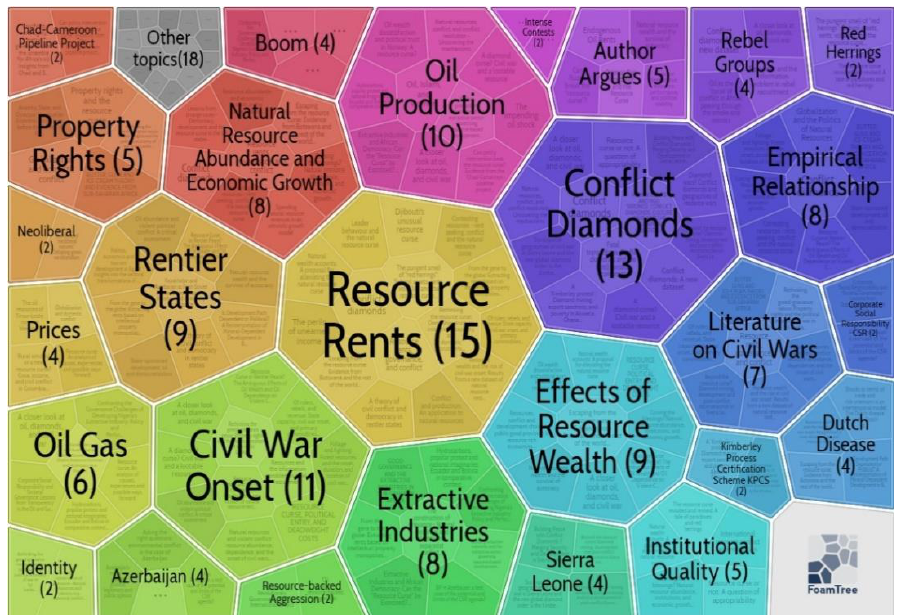
Figure 26. Keywords in Cluster 5 (using Carrot2 4.3.1).